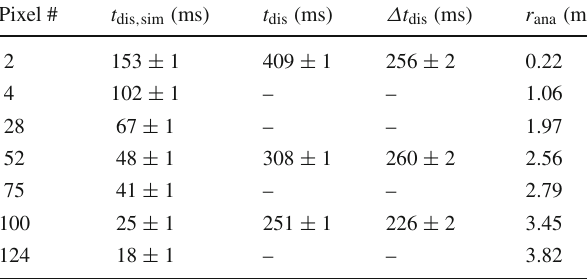
Table 4 Pulse timing for different detector pixels. The table shows the measured and simulated beam disappearance times at the detector, t dis and t dis , sim , and the calculated difference Δ t dis = t dis − t dis , sim . The individual detector pixels correspond to different radial positions r ana in the analyzing plane of the